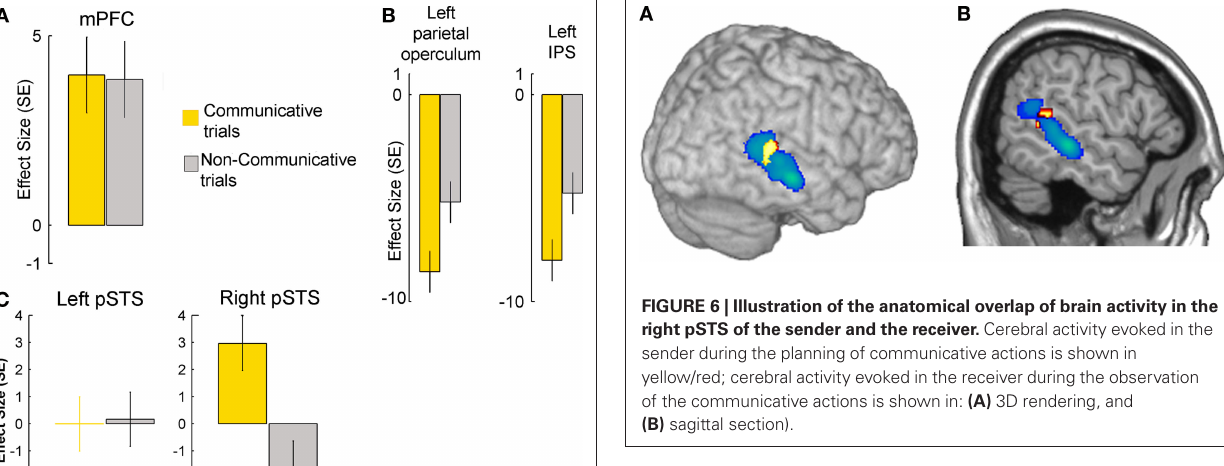
showed a signifi cant difference between the two trial types, but this receiver’s token required when solving the diffi cult